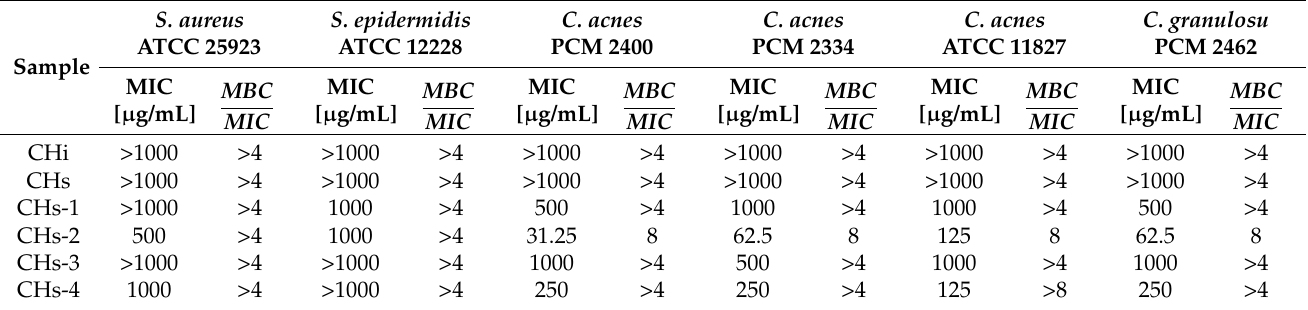
Table 8. Minimum inhibitory concentration (MIC) and minimum bactericidal concentration of the fractions of C. hsingshangensis crude